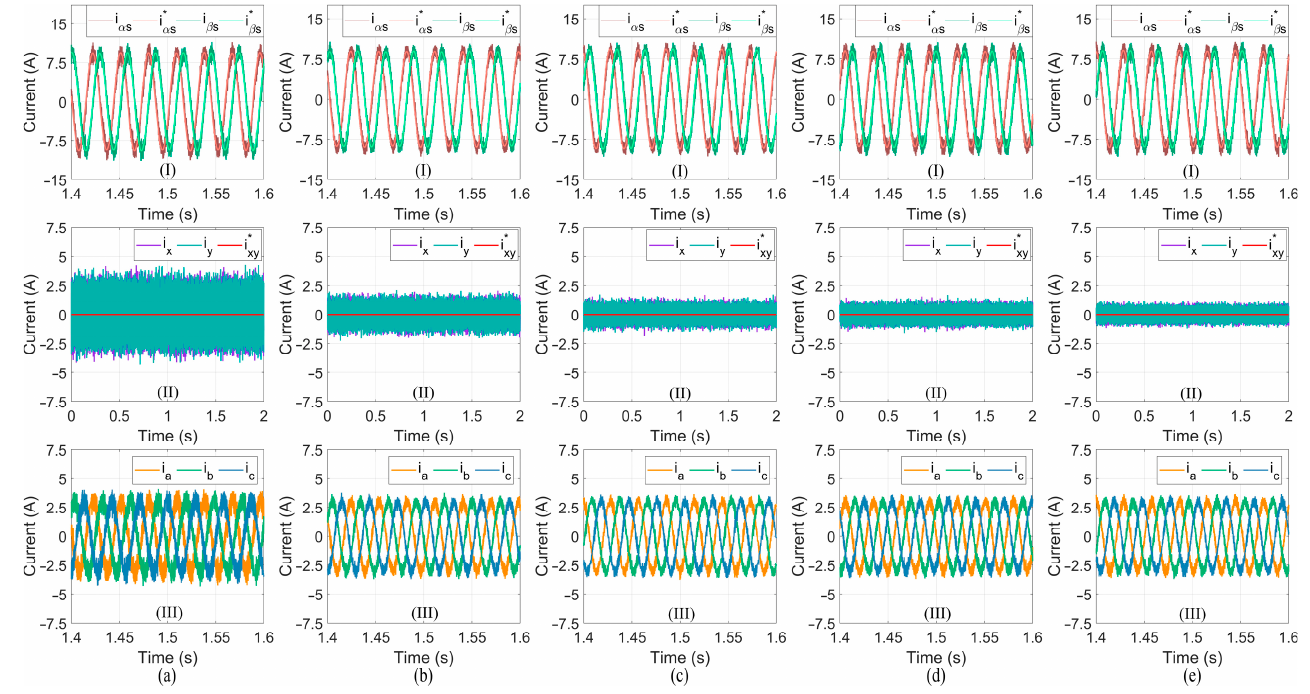
Figure 8. Test 1: HCC (( a ) plots), HPCC (( b ) plots), MPC49 (( c ) plots), MPC13 (( d ) plots), and the proposed HMPCC (( e ) plots)). From top to bottom: (I) α and β currents; (II) x and y currents; (III) the a, b, and c phase currents.